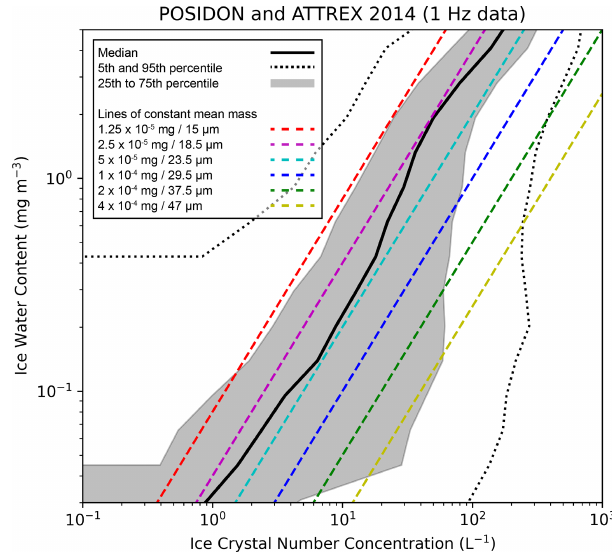
Figure 2. Statistics of ice water content (IWC) are shown as a func- tion of ice crystal number concentration (NI) for 1Hz data from POSIDON and ATTREX 2014. The solid line is the median, the dot- ted lines are the 5th and 95th percentiles, and the shaded area spans the range of the 25th to 75th percentiles. Colored dashed lines indi- cate constant mean particle mass. The legend lists the mean masses and the corresponding mean equivalent sphere radii for each colored